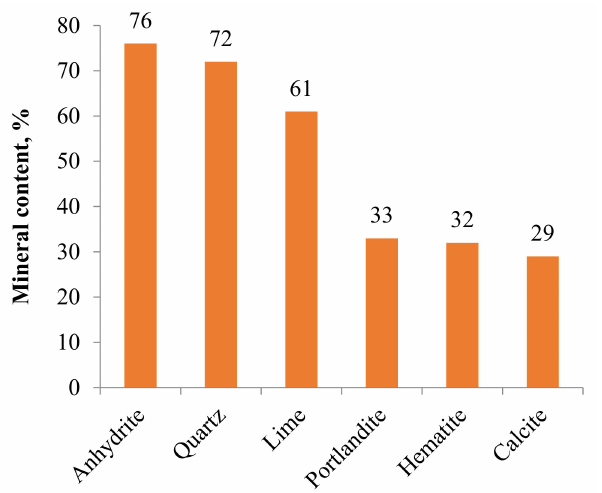
Figure 9. Crystalline phases for different FAs [103]. Reprinted with permission from MDPI